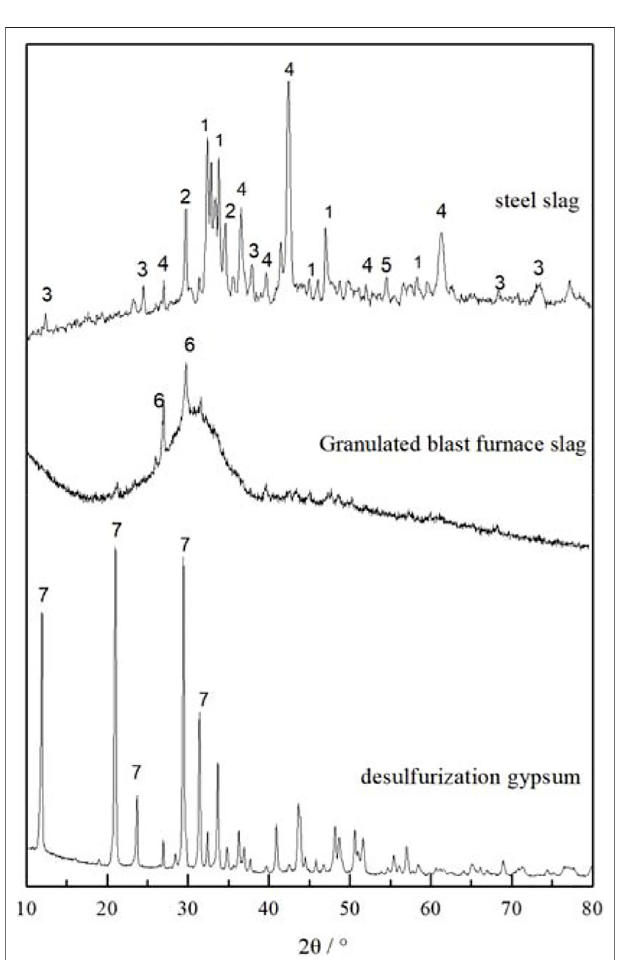
FIGURE 1 | XRD scans of raw materials, Peaks of the different mineral phases are numbered 1-Dicalcium silicate (C 2 S)2-Tricalcium silicate (C 3 S)3- Dicalcium ferrite (C 2 F) 4-FeO/MgO(RO phase) 5-f-CaO 6- Gehlenite (C 2 AS) 7- CaSO